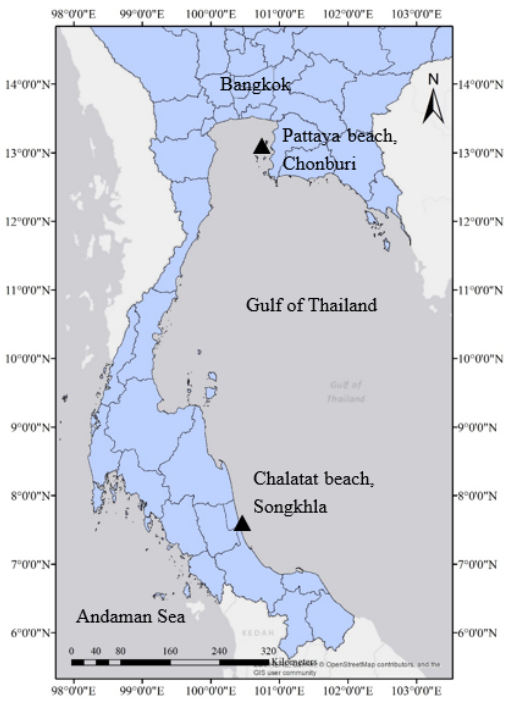
Figure 1. Study areas.